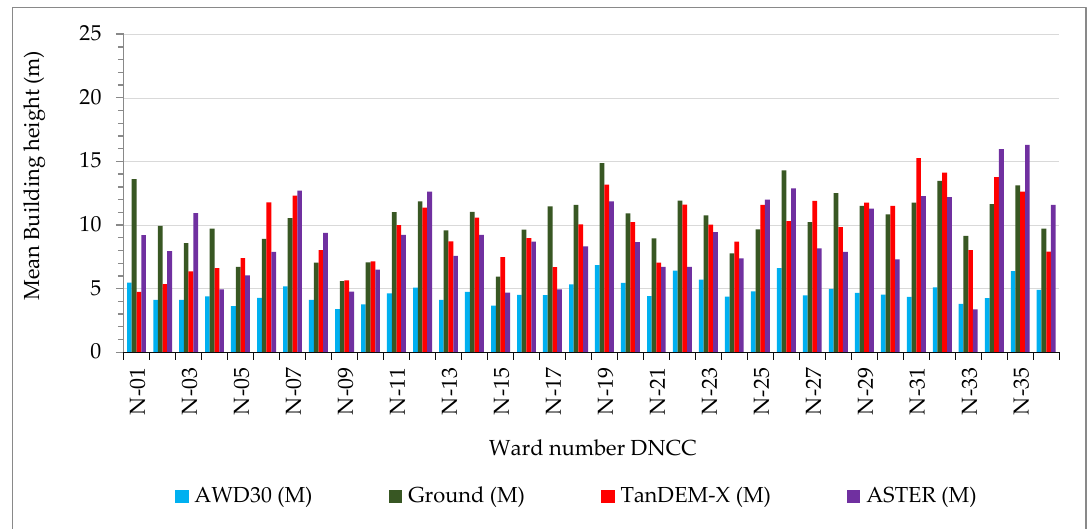
Figure 8. Ward-wise (small administrative boundary) mean building height of Dhaka North City Corporation (DNCC).